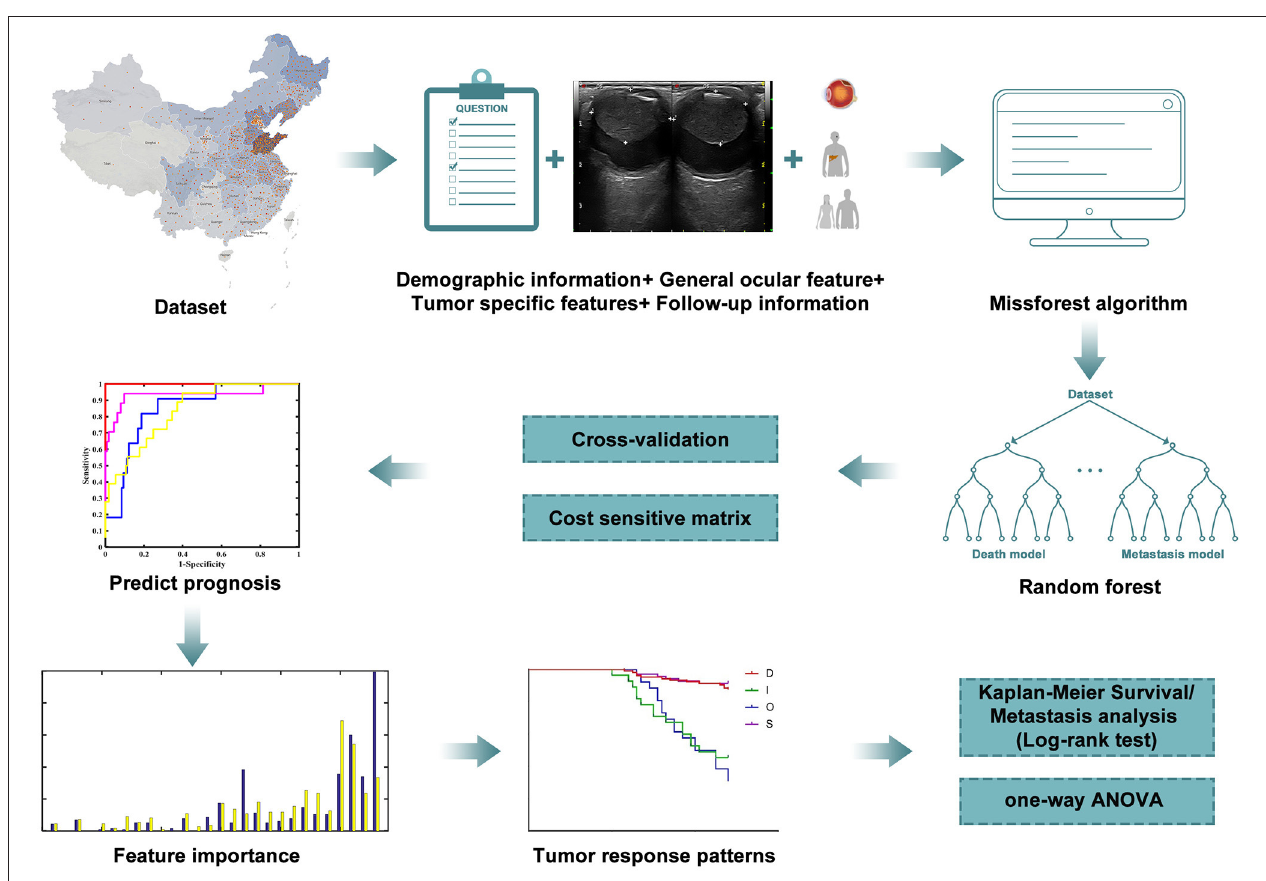
FIGURE 1 | Workflow of the research. Machine learning was carried out according to the clinical and follow-up data from patients to predict the prognosis. Results of metastasis and survival analysis are based on filtered